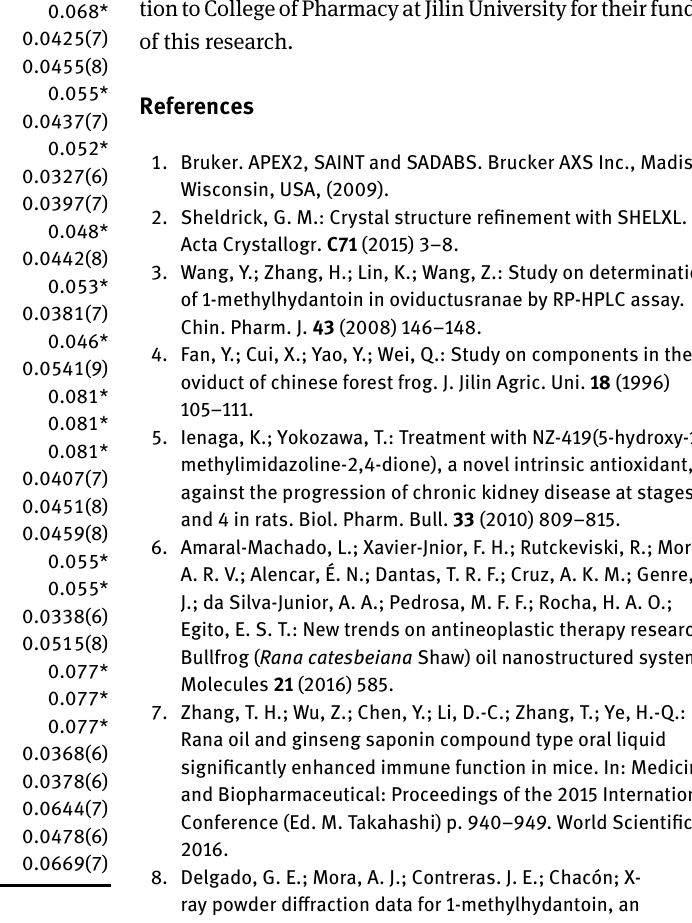
The asymmetric unit of the title crystal structure consists of one molecule. There are no hydrogen bonds between ad- jacent molecules. All bond lengths and angles are in the ex- pected ranges. The imidazole ring and the phenyl ring are not on the same plane, the bond lengths of C13—N1, C14—N1 and C16—N1 are 1.423(4) Å, 1.437(3) Å and 1.411(4) Å, respectively. The angles of C14—N1—C13, C14—N1—C16 and C13—N1—C16 are 124.1(2)°, 109.7(2)°, 125.9(2)°,